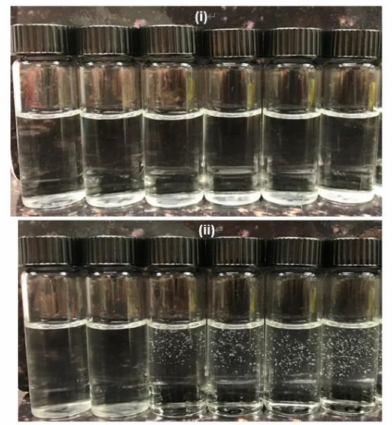
Figure 5. Photographs of remediation experiments ( i ) 5 mL of 0.02 wt% of 6CC mixed with 5 mL of varying concentration of Pb 2+ (left to right: 5, 10, 25, 50, 100 and 250 ppm), ( ii ) 5 mL of 0.02 wt% of TCC mixed with 5 mL of varying concentration of Pb 2+ (left to right: 5, 10, 25, 50, 100 and 250